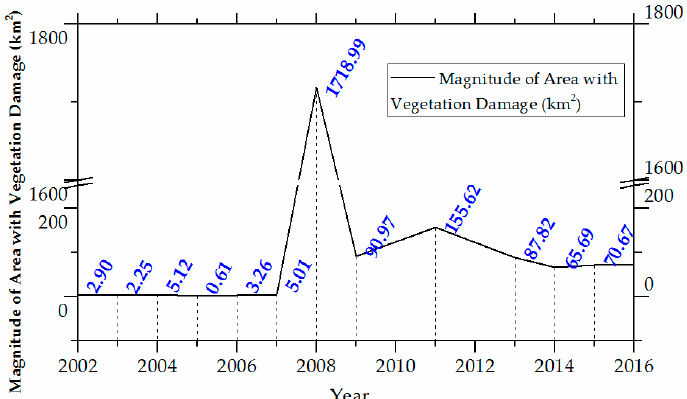
Figure 8. Change in AVD caused by geohazards in the study area of 10 Counties / Cities from 2002 to 2016.